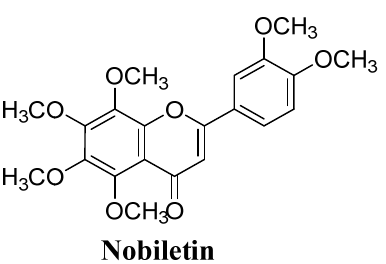
Figure 9. Nobiletin. Orientin is a C-glycosyl flavonoid, i.e., luteolin substituted with β -D-glucopyranosyl